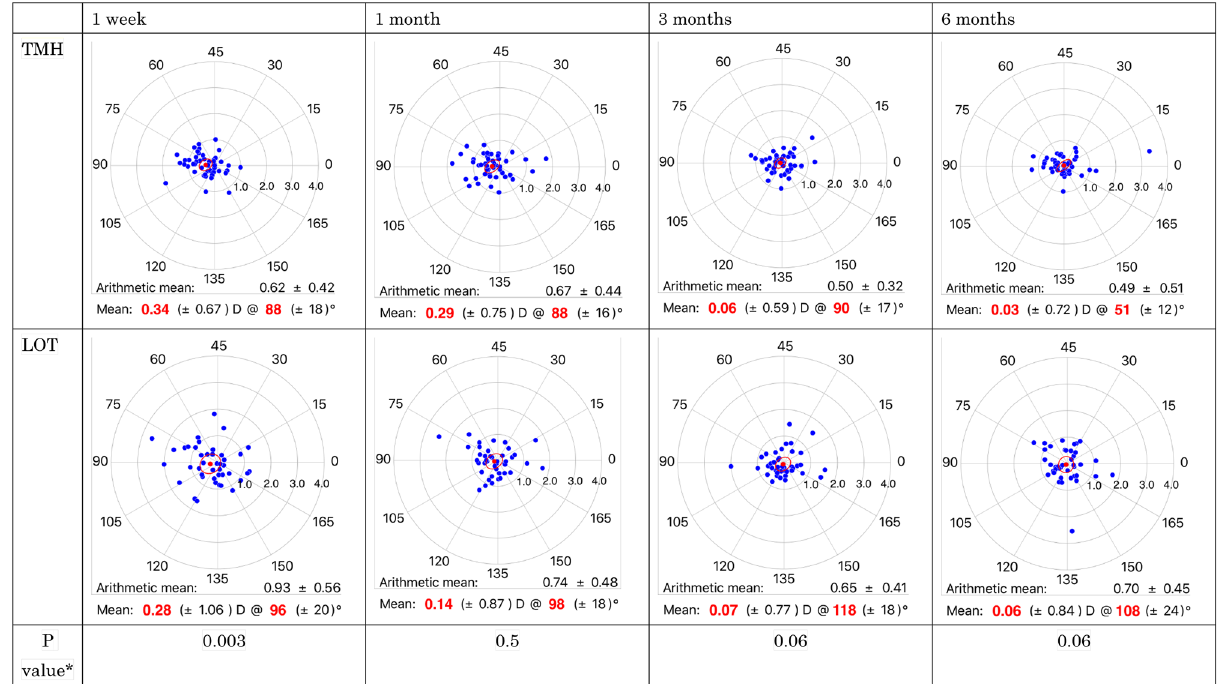
Figure 4. A scatter plot of SIA in TMH and LOT. SIA: surgical induced astigmatism. The red and blue dots in each chart indicate the mean SIA vectors of each group and each time points and the SIA of each eye, respectively. The red circle indicates 95% confidence interval. All the astigmatic values are expressed in a plus- cylinder format. The astigmatism in the direction of 0° indicates against the rule astigmatism, and that in the direction of 90° indicates with the rule astigmatism. Each ring indicates about 1.2 or 1.3D. *Calculated using linear mixed model in surgical induced astigmatism between TMH and LOT. TMH LOT P